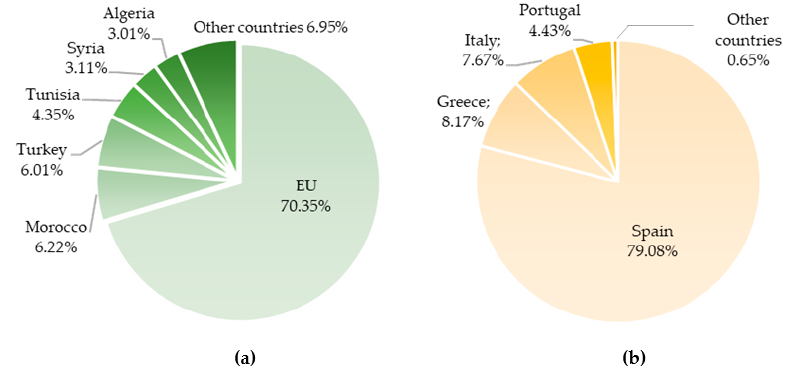
Figure 2. Production of olive oil. Provisory data from the campaign year 2018 / 2019: ( a ): World production; ( b ): European production (data from IOC [10]).